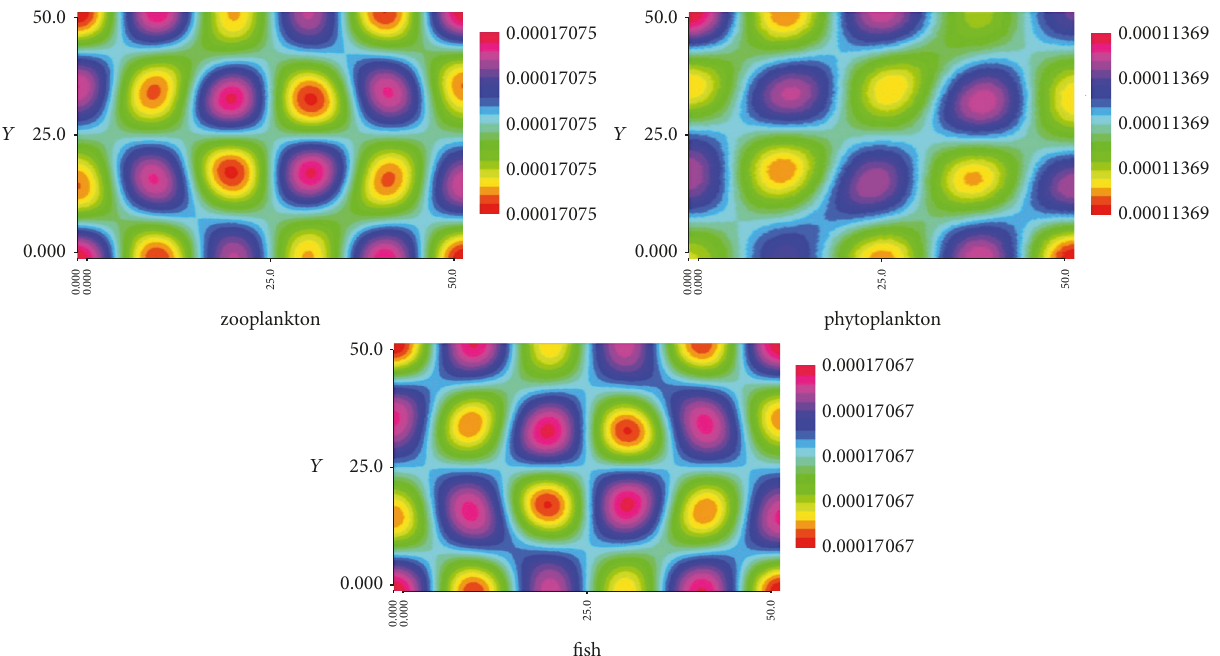
Figure 7: Spatial distribution of the system with 𝑏 0 = 0.69 and 𝛼 0 = 0.595